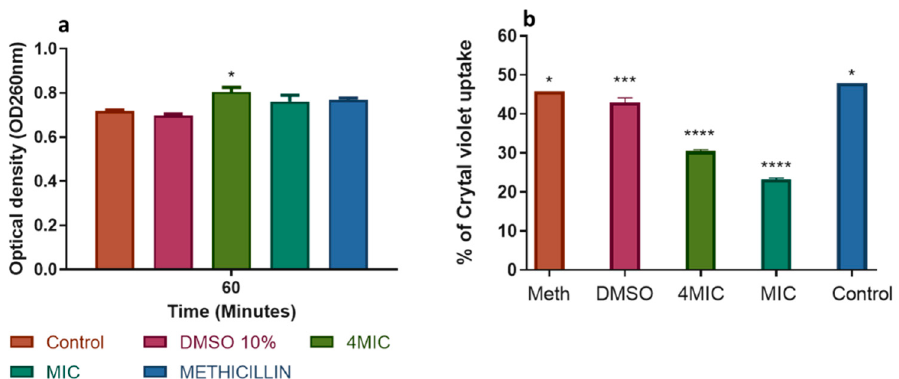
Figure 4. Modes of action of P. huayllabambana n-hexane fraction on S. enterica cell membrane. ( a ) Action on cell membrane integrity. Absorbance measurement of intracellular components (DNA, RNA) at OD260 nm after 1 h of incubation. ( b ) Action on membrane permeability. All data are expressed as mean ± SD ( p < 0.05). Meth: methicillin. MIC: minimum inhibitory concentration.